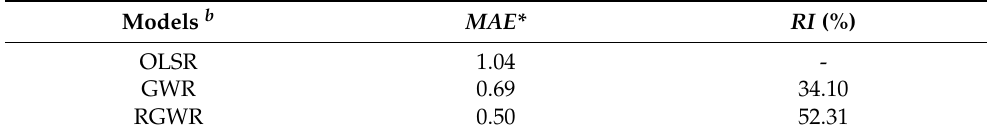
Table 4. Parameters of the optimal robust variogram models.